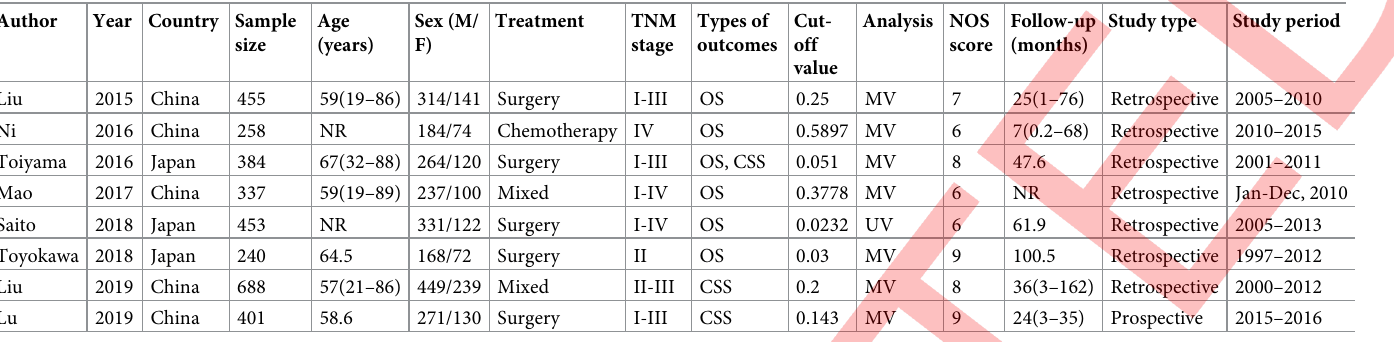
M, male; F, female; NR, not reported; OS, overall survival; CSS, cancer-specific survival; MV, multivariate; UV, univariate; NOS, Newcastle-Ottawa Scale; TNM, tumor node